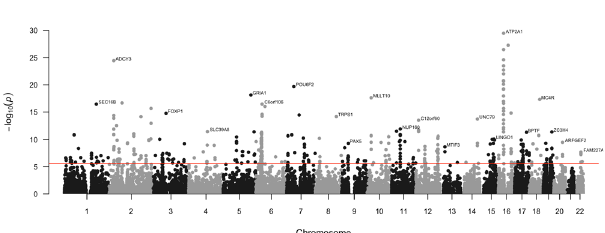
Figure 1. Manhattan plot of genetic associations with grip strength in discovery sample.